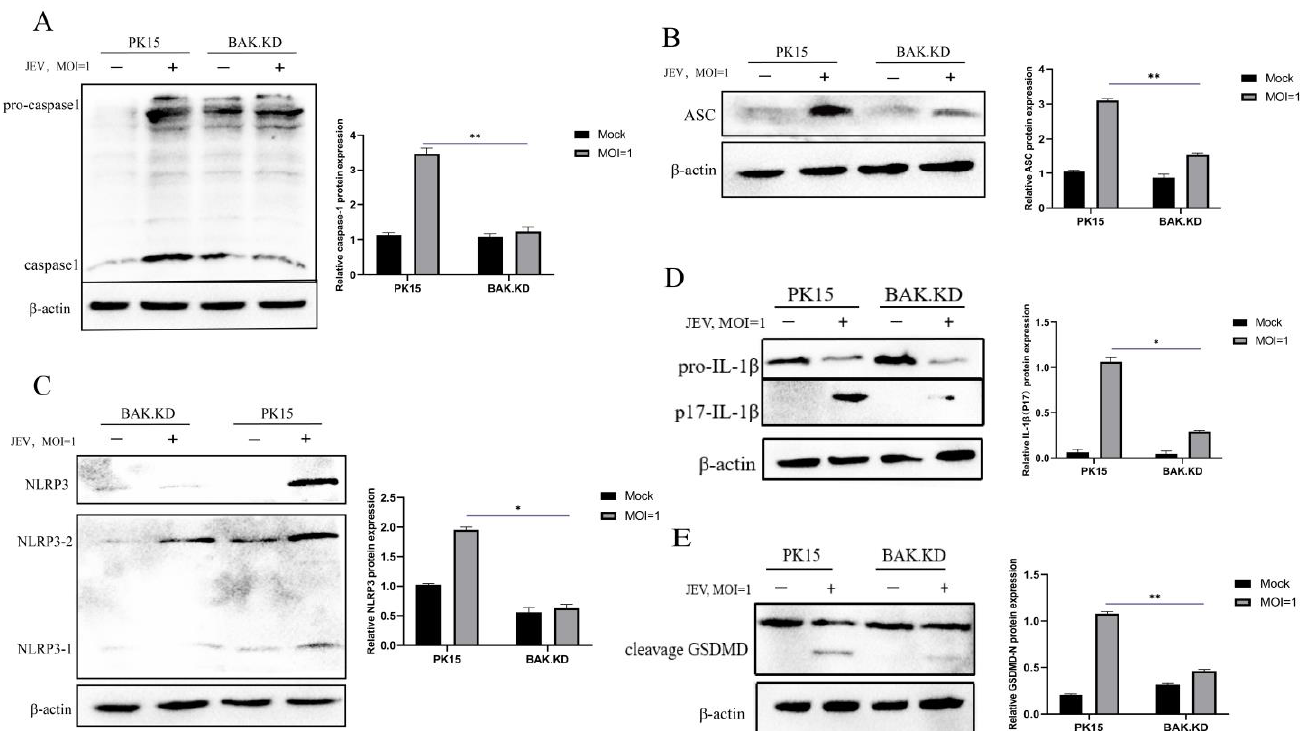
Figure 4 . The activation of NLRP3 inflammatory pathway proteins induced by JEV is significantly inhibited in BAK.KD cells. Changes in protein levels during late pyroptosis were determined by Western blotting. The experimental group (JEV, MOI = 1, 48 hpi) and the control group (Mock) exhibited the expression levels of several endogenous proteins. ( A ) Caspase-1, ( B ) ASC, ( C ) NLRP3, ( D ) IL-1β, ( E ) GSDMD, and β-actin as an internal control. Three independent replicates were set for each experiment, and the experimental results were averaged for processing. * ( p < 0.05), ** ( p < 0.01).